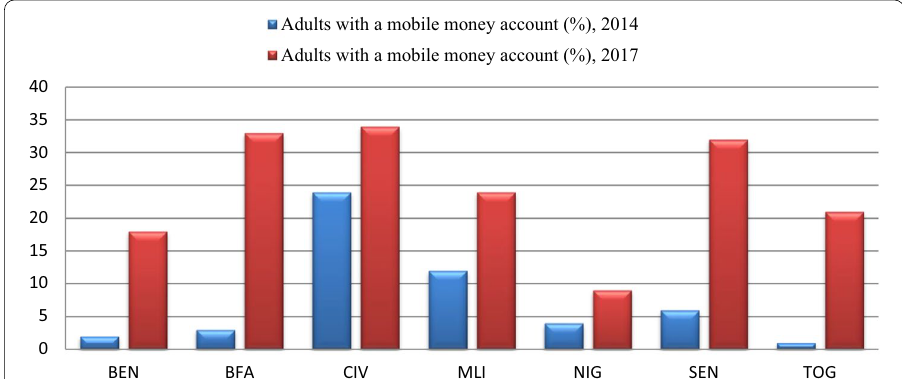
WAEMU counties ( Benin , Burkina Faso , Côte d’Ivoire , Mali , Niger , Senegal , Togo ) in terms of access to